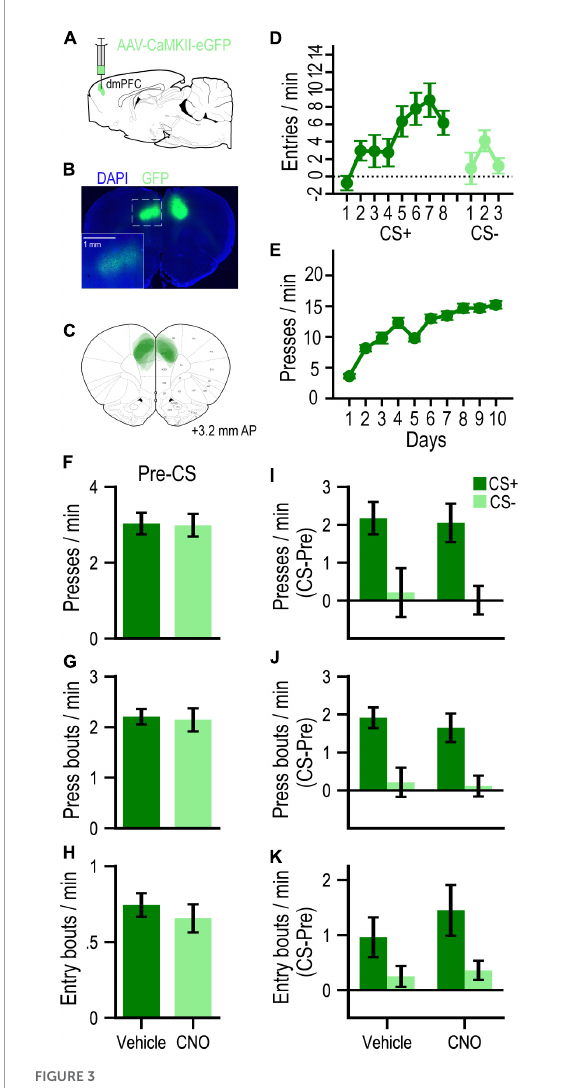
FIGURE3 (A) Schematic of AAV strategy for expressing GFP in dmPFC. (B) Representative GFP expression. (C) Localization of expression for all rats in this experiment. (D) Mean cue-evoked food-port entry rate (entries/min; CS – Pre; ± SEM) during